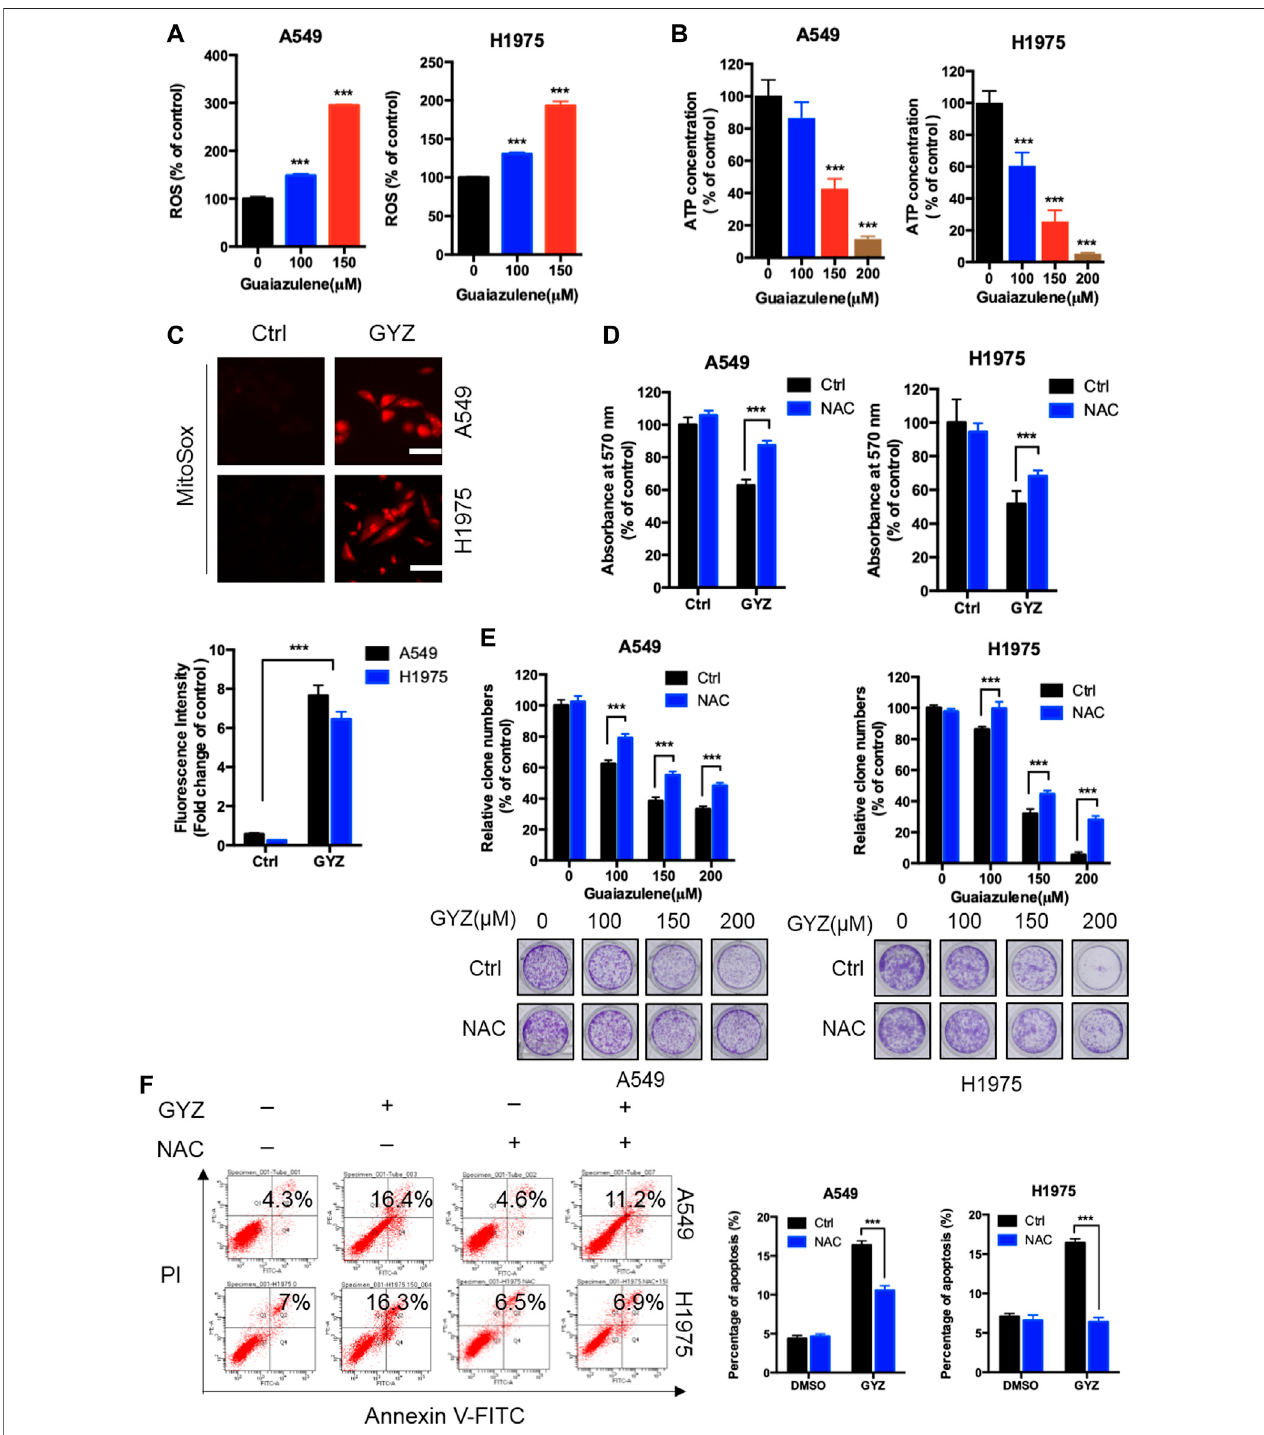
FIGURE 3 | ROS accumulation are responsible for anti-NSCLC effects of GYZ in vitro . (A) ROS level was measured by DCFH-DA staining through a fl uorescence microplateReaderinNSCLC cellstreatedwiththeindicatedconcentrationsofGYZ. (B) Mitochondrialmassanalyzed byATPcontentmeasurementinA549andH1975 cells treated with the indicated concentrations of GYZ. (C) Mitochondrial ROS accumulation was detected using MitoSOX Red in NSCLC cells treated with or without GYZ. (D) TheMTTassaydeterminedcellviabilityofNSCLCcellstreatedwithGYZ(100 μ M)intheabsenceorpresenceof2 mMNACfor48 h. (E) Colonyformation assayofNSCLC cellstreatedwiththeindicatedconcentrationsofGYZintheabsenceorpresence of2 mMNAC. (F) AnnexinV – FITC/PI stainingwasused todetectthe apoptotic effects induced by GYZ (150 μ M) in the absence or presence of 2 mM NAC for 48 h in NSCLC cells. Scale bars, 25 μ m. All data are means ± SD. * p < 0.05, ** p < 0.01, *** p <